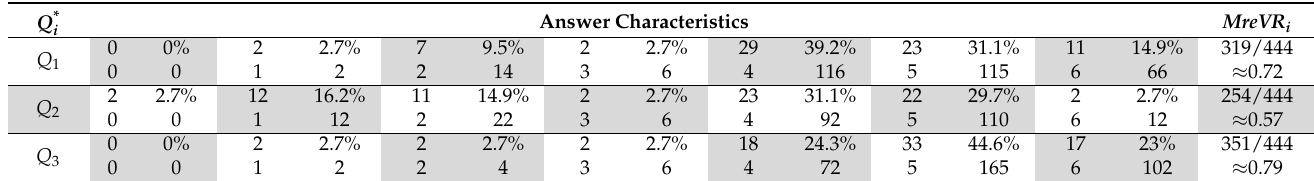
Table 1. Awareness of sustainable marketing mix development.